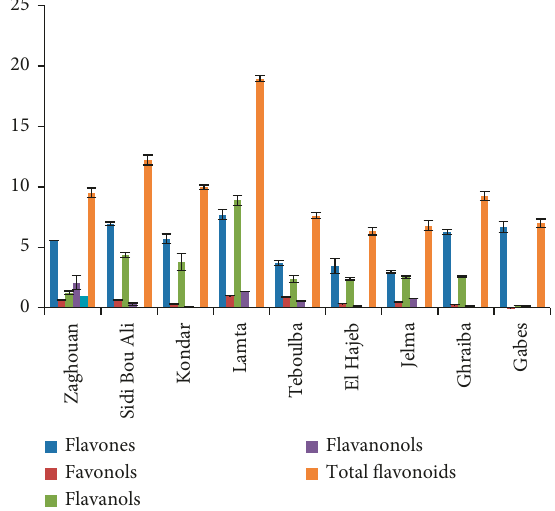
Figure 5: Variation in the distribution of flavonoids in “Chemlali” olive leaf extracts according to the cultivation